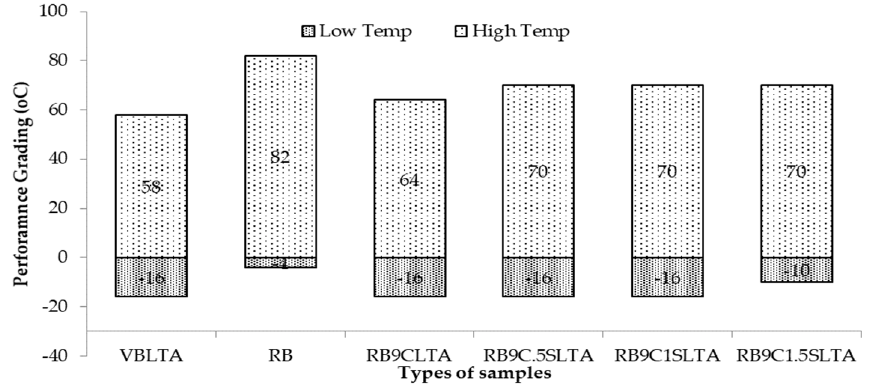
Figure 9. Effect of rejuvenation and aging on PG grading of asphalt binders. Figure 9. E ff ect of rejuvenation and aging on PG grading of asphalt